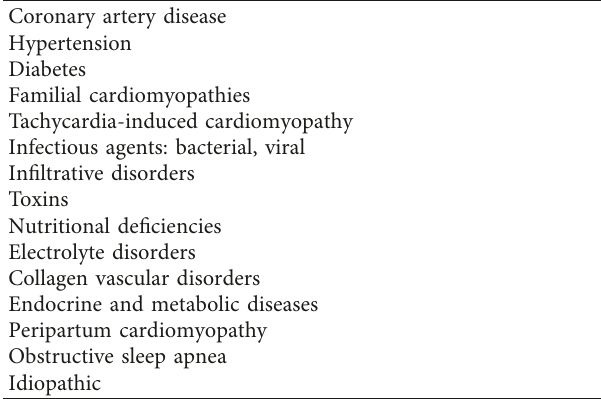
Table 1: Differential diagnosis for etiologies of heart failure with reduced ejection fraction